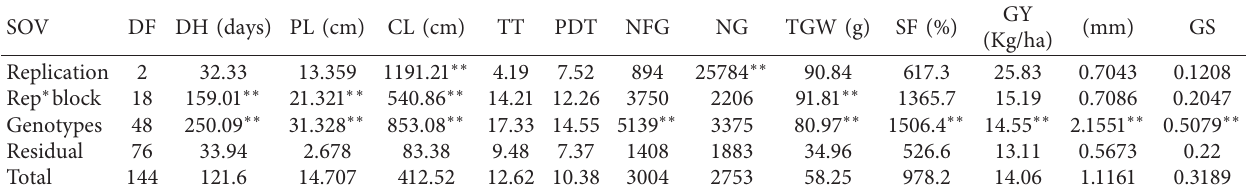
Table 4: Mean squares analysis for agronomic traits of forty-nine rice genotypes under irrigated conditions. SOV